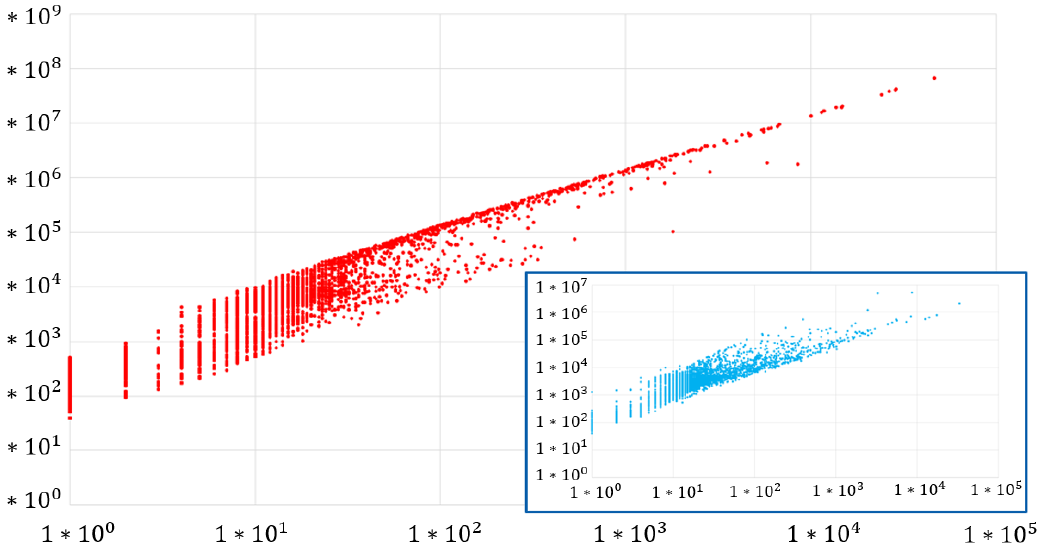
Figure 10. Downlink (red) and uplink (blue) traffic flow distribution of APN “C” (x axis: number of packets, y axis: Size of flows